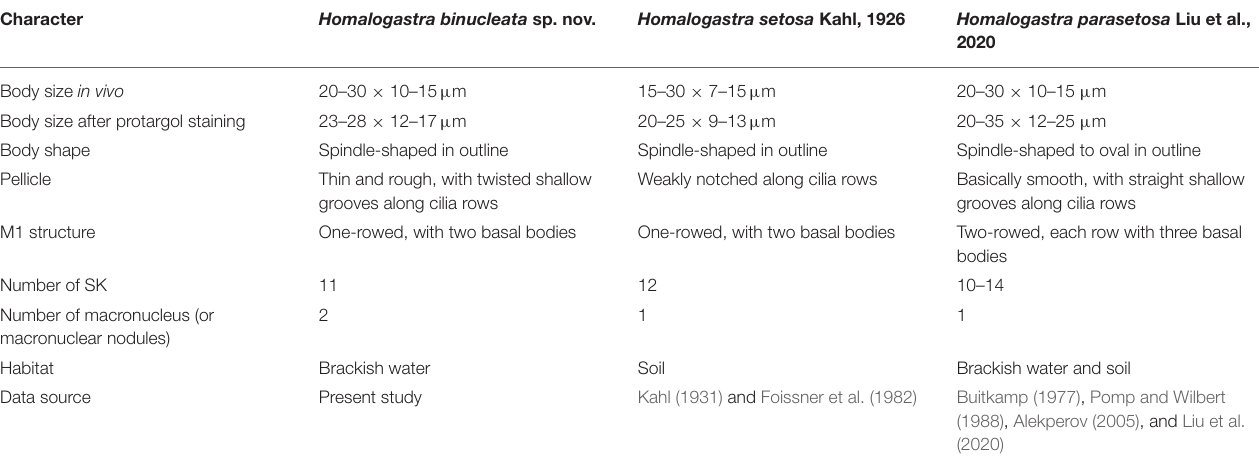
TABLE 3 | Comparison of Homalogastra binucleata sp. nov. with